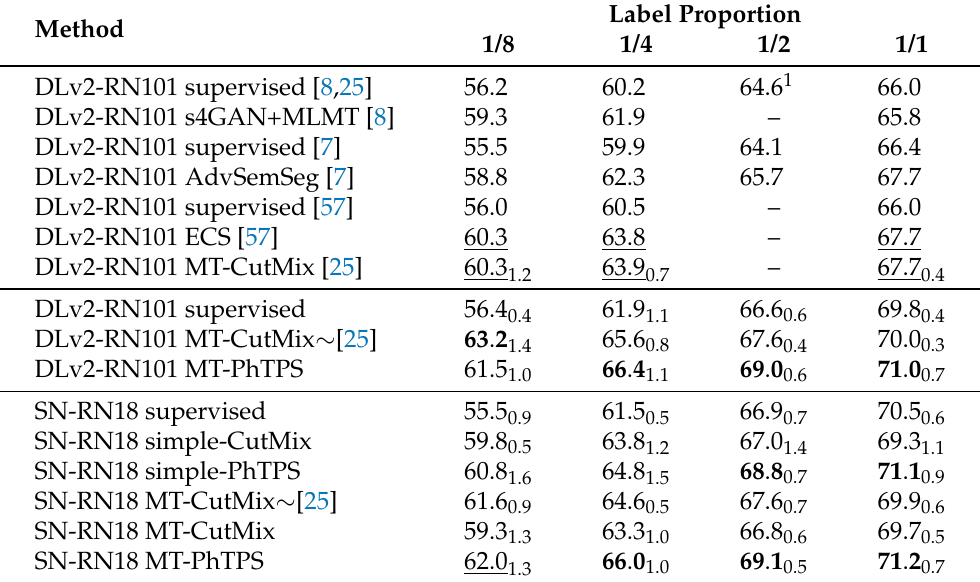
Table 1. Semantic segmentation performance (mIoU/%) on half-resolution Cityscapes val after training with different proportions of labeled data. The top section reviews experiments from previous work. The middle section presents our experiments with DeepLab v2. The bottom section presents our experiments with SwiftNet-RN18. We run experiments across 5 different dataset splits and report mean mIoUs with standard deviations. The subscript “ ∼ [25]” denotes training with L 2 loss, confidence thresholding, and α = 1, as proposed in [25]. The best results overall are bold, and best results within sections are